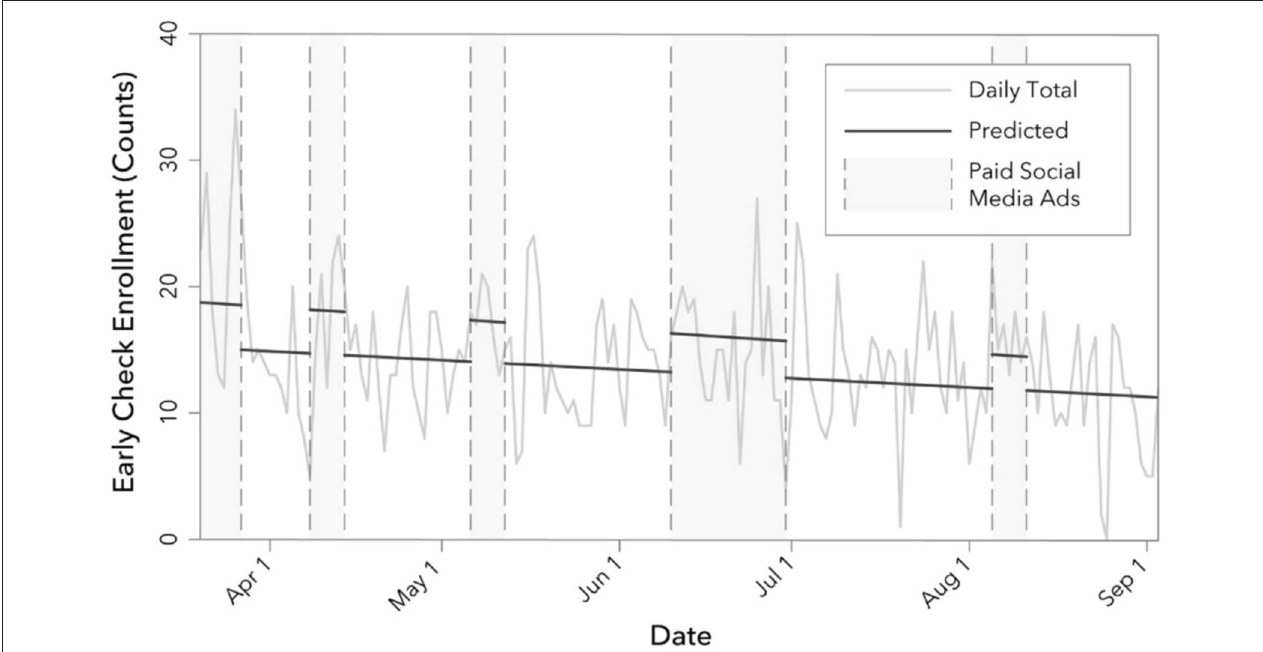
FIGURE 3 | A time series plot showing the daily number of Early Check enrollments from March 20, 2019, through September 3, 2019 and predicted values comparing days with or without paid social media ads. Predicted values control for seasonality and holiday